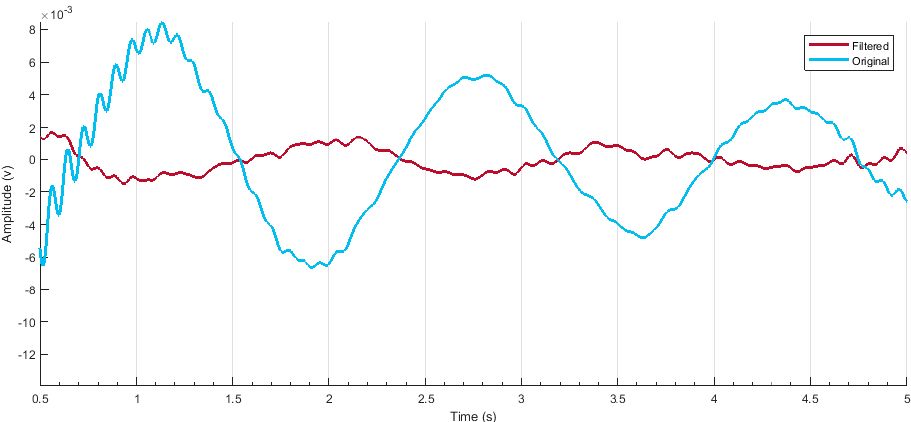
Figure 12. The filtered sample after the implementation of band-pass filter in a range of 0.01 Hz–0.2